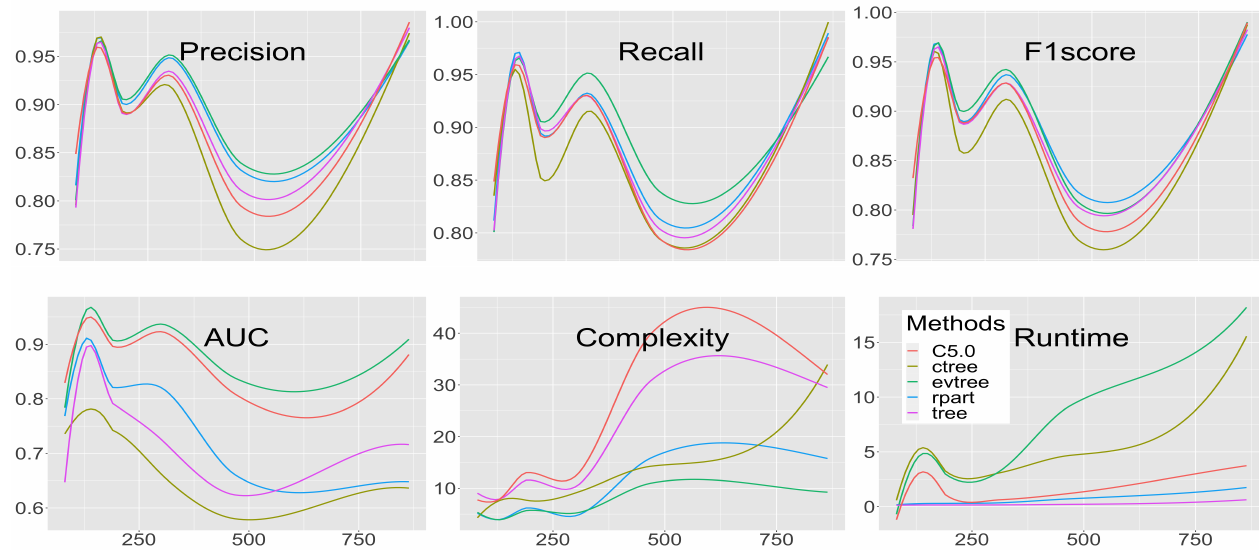
Figure 1. Sample sizes ( x -axis) versus Precision, Recall, F 1 Score , Area Under the Curve (AUC), Complexity and Runtime ( y